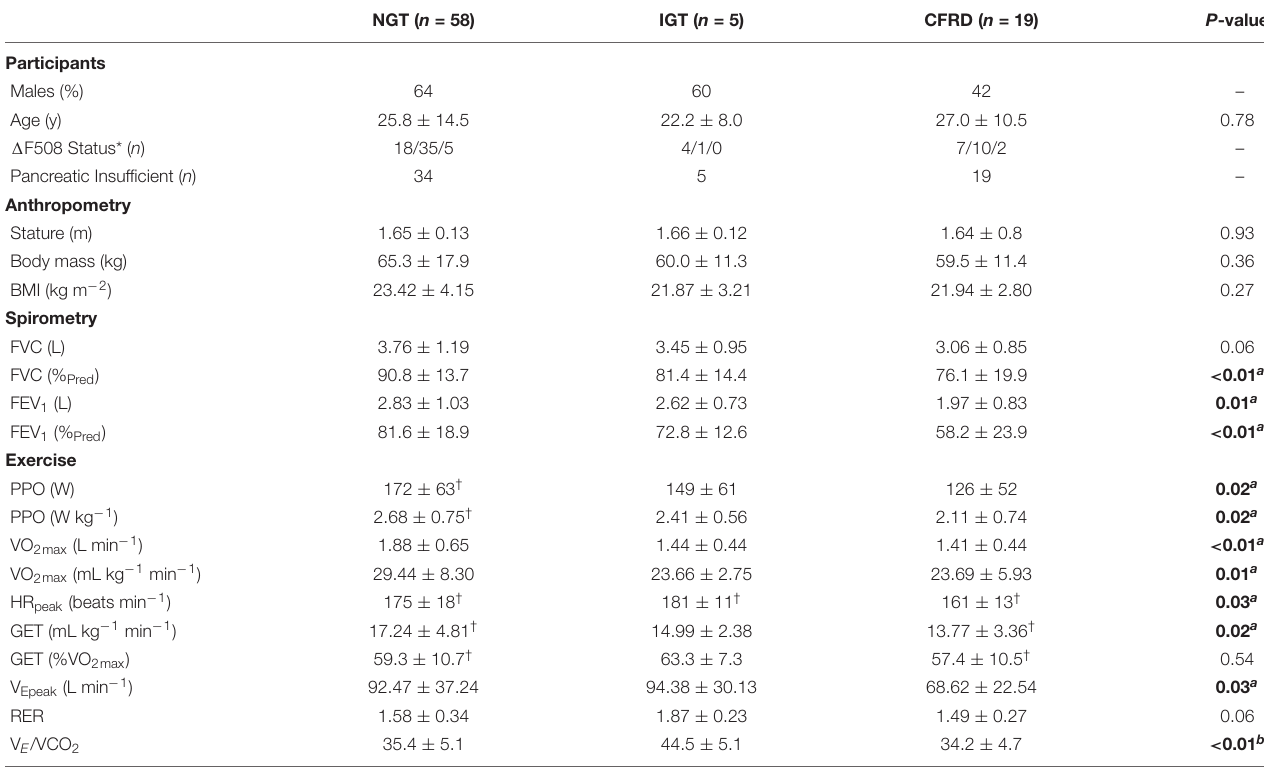
TABLE 1 | Participant characteristics including anthropometry, pulmonary function, and exercise-based outcomes at baseline